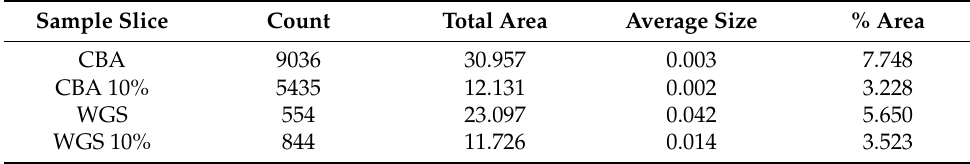
Table 8. Analysis of pores by Image